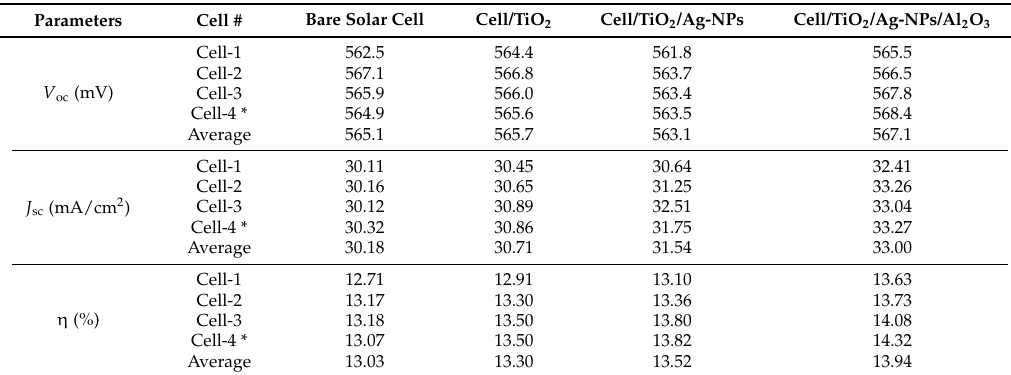
Table 1. Photovoltaic performance of four bare cells, cells with a TiO 2 spacer layer, cells with Ag-NPs, and cells with Ag-NPs embedded in Al 2 O 3 .